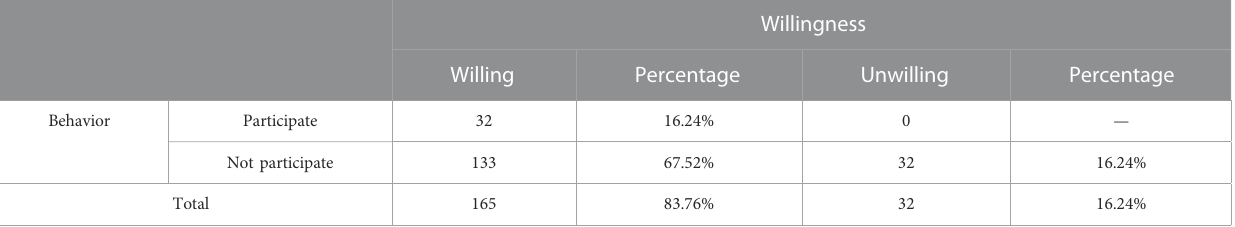
TABLE 3 Willingness and actual behavior of respondents to participate in the management of SJLNNR.